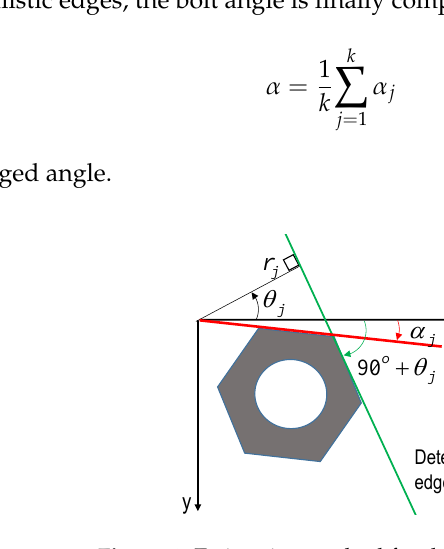
Figure 4. Estimation method for the bolt angle.